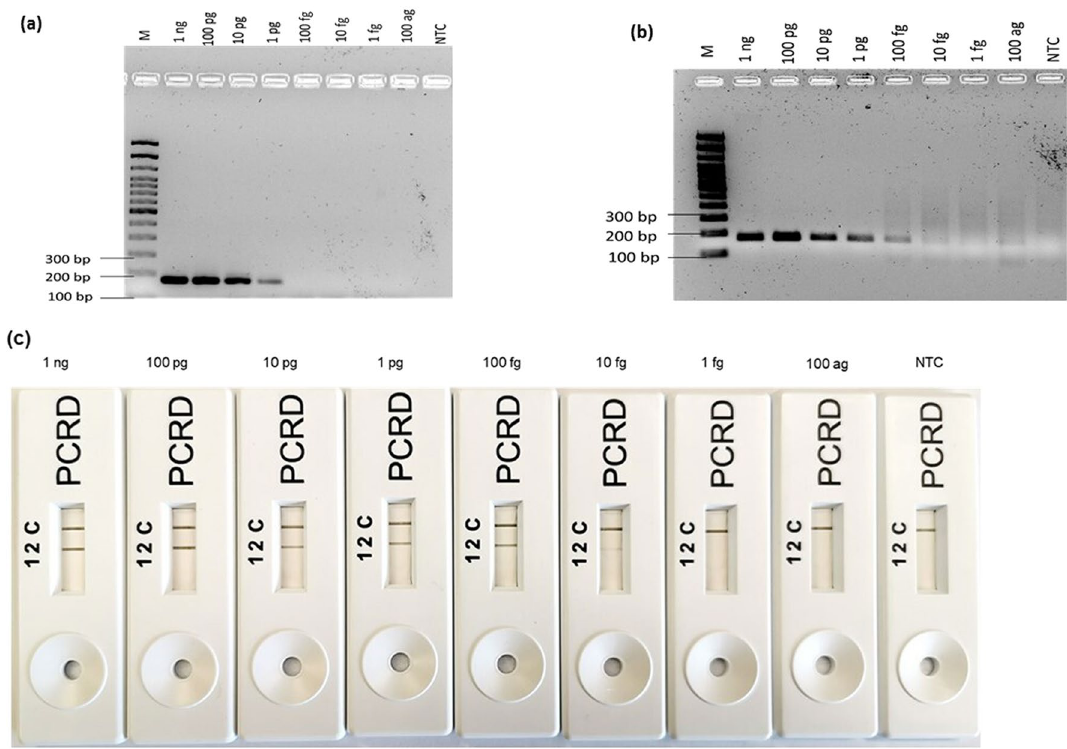
Figure 4. Sensitivity evaluation of the RPA-LFA using fliC F2/R2 to detect various DNA concentrations of E. coli O157:H7. From left to right 1 ng to 100 ag and non-template control (NTC). ( a ) By PCR-AGE, ( b ) by RPA- AGE assay, ( c ) by